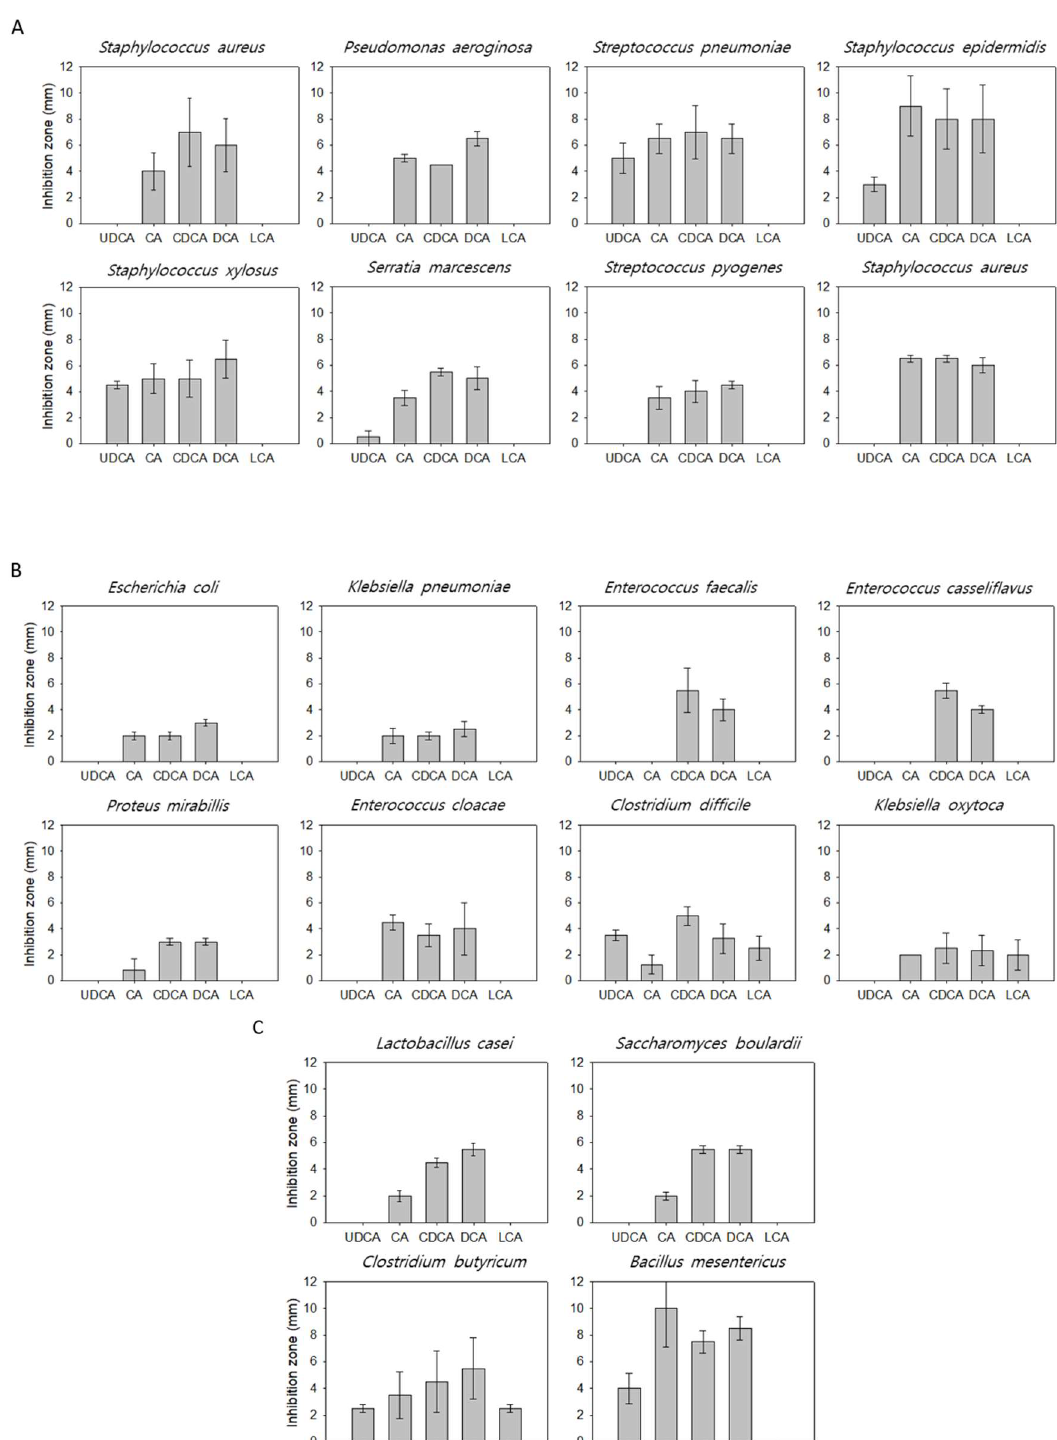
Figure 1. ( A ). Susceptibility of strains found outside the intestine to bile acids. ( B ). Susceptibility of strains mainly observed in the intestine and biliary system to bile acids. ( C ). Susceptibility of commercially available probiotics to bile acids.